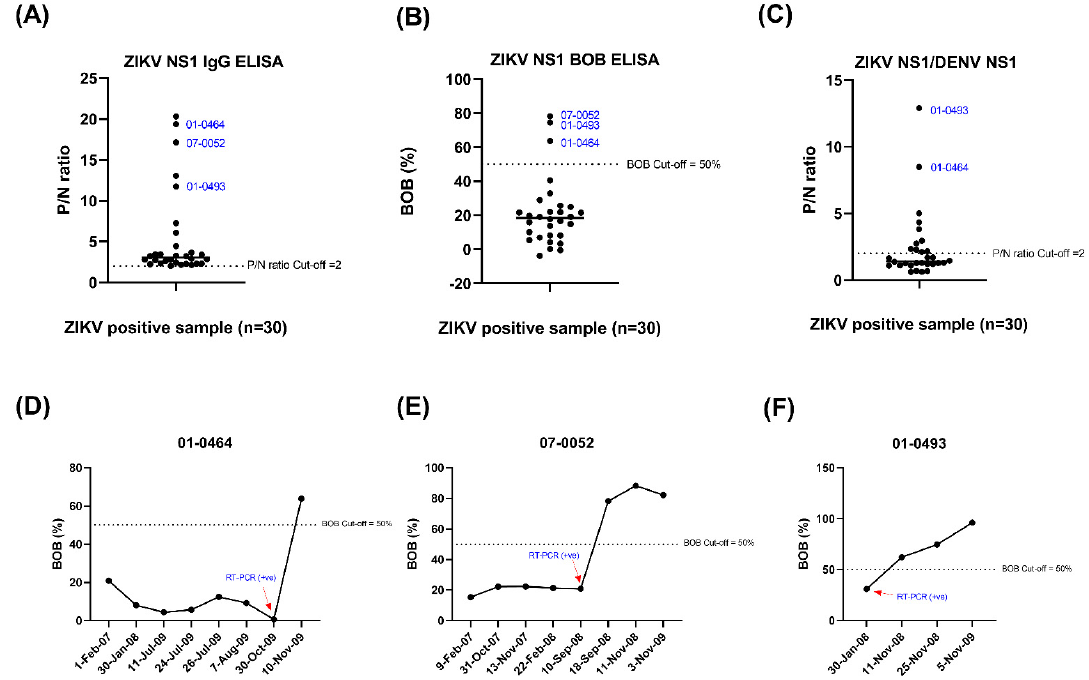
Figure 2. Performance of serological assay using ZIKV infection samples in the convalescent phase. ( A ) ZIKV NS1 ELISA. The dotted line represents the cut-off value of the P/N ratio. ( B ) ZIKV NS1 BOB ELISA. The dotted line represents the cut-off value of % BOB inhibition. ( C ) ZIKV NS1/DENV NS1 ELISA. The dotted line represents the cut-off value of the P/N ratio. ( D – F ) ZIKV NS1 BOB ELISA in a sequential annual blood sample of three ZIKV infection patients (01-0464, 07-0052, and 01-0493). The red arrow indicates the date of ZIKV RT-PCR positivity. The dotted lines represent the cut-off value of % BOB inhibition. ZIKV: Zika virus, DENV: dengue virus, ELISA: enzyme-linked immunosorbent assay, BOB: blockade-of-binding, NS1: nonstructural protein 1, P/N ratio: ratio of average OD 450 of test sample divided by the average OD 450 of the negative sample.